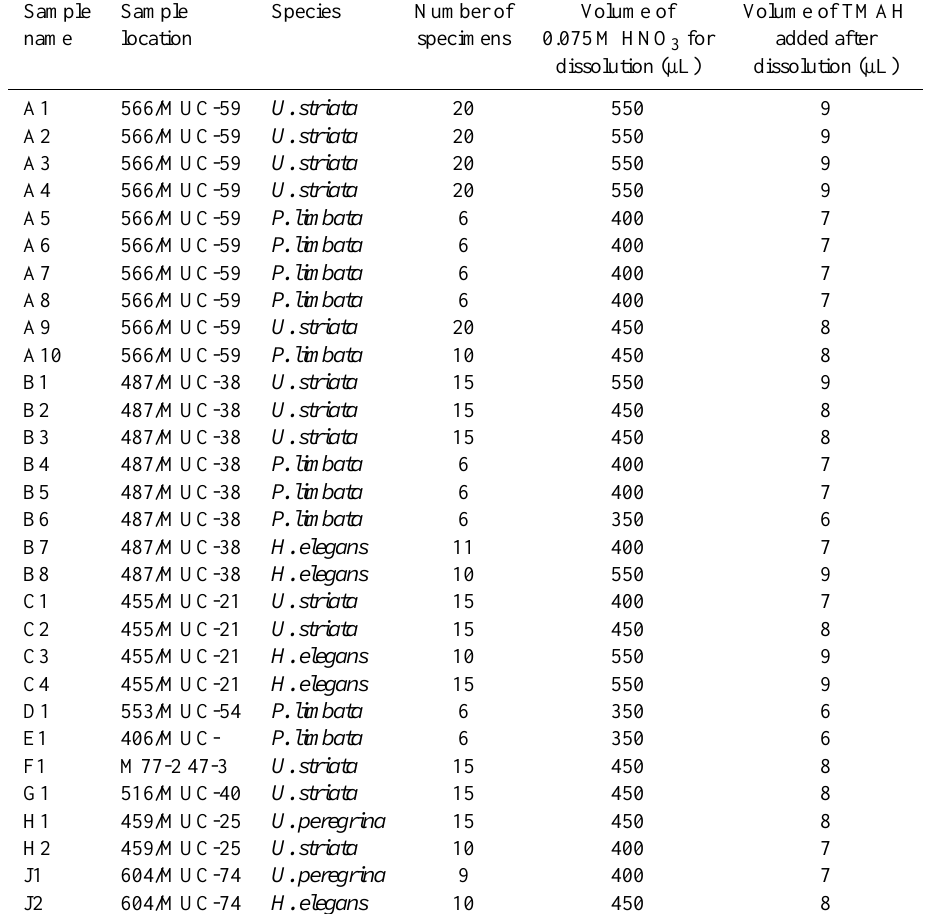
Table 2. Details for analysed foraminiferal samples. Note that TMAH was added after transfer of the centrifuged dissolved sample into a clean vial. Thus, the volume of 0.0075M HNO 3 is reduced by 50µL when TMAH is added (see text in Sect.